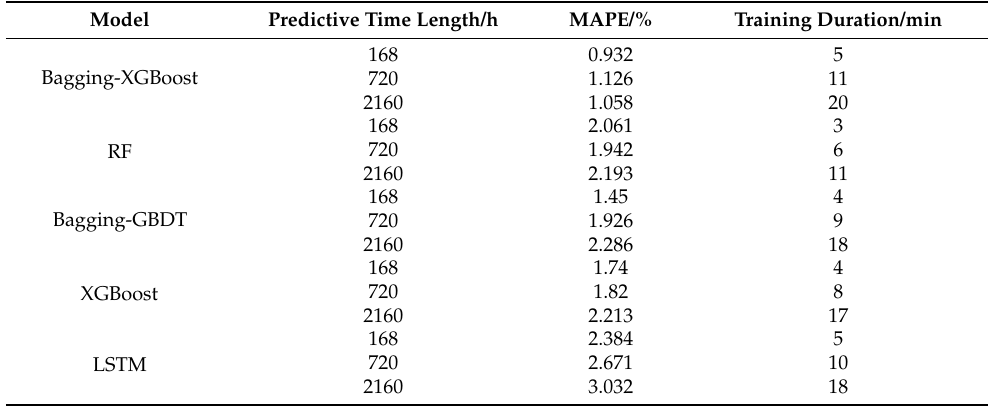
Table 8. Electrical load prediction errors of different models with different predicting step sizes. Model Predictive Time Length/h